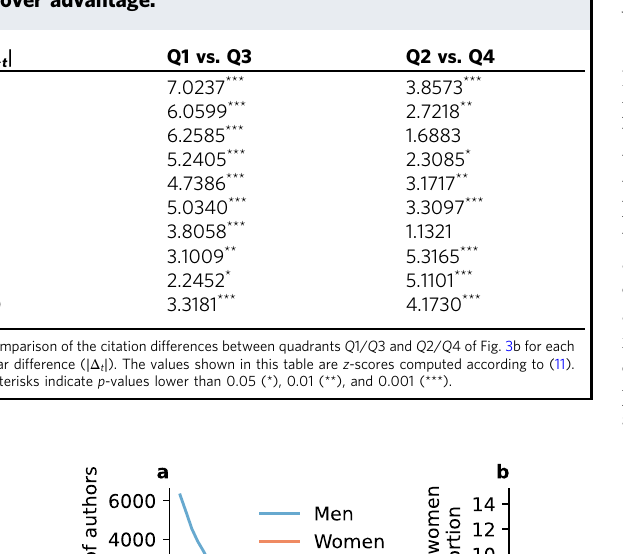
Table 3 Statistical tests of gender asymmetry in the fi rst- mover advantage.